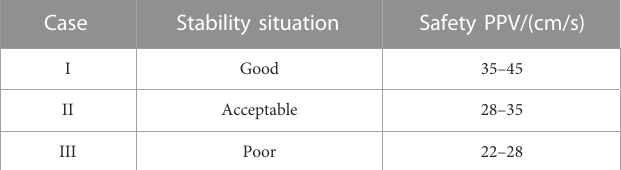
TABLE 1 Safety blasting vibration velocity for open mines (Luo et al., 2010).